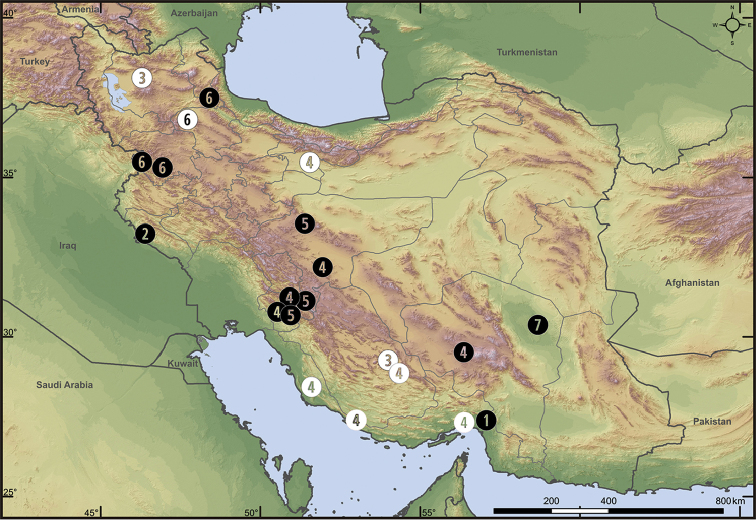
Distribution of Pterotricha spp. and Iranotrichalutensis Zamani & Marusik, sp. n. in Iran (white symbols refer to literature records, and black symbols refer to our new data): 1P.cf.dalmasi2P.kovblyuki Zamani & Marusik, sp. n. 3P.lentiginosa (?) 4P.strandi5P.montana Zamani & Marusik, sp. n. 6P.pseudoparasyriaca7I.lutensis Zamani & Marusik, sp. n.